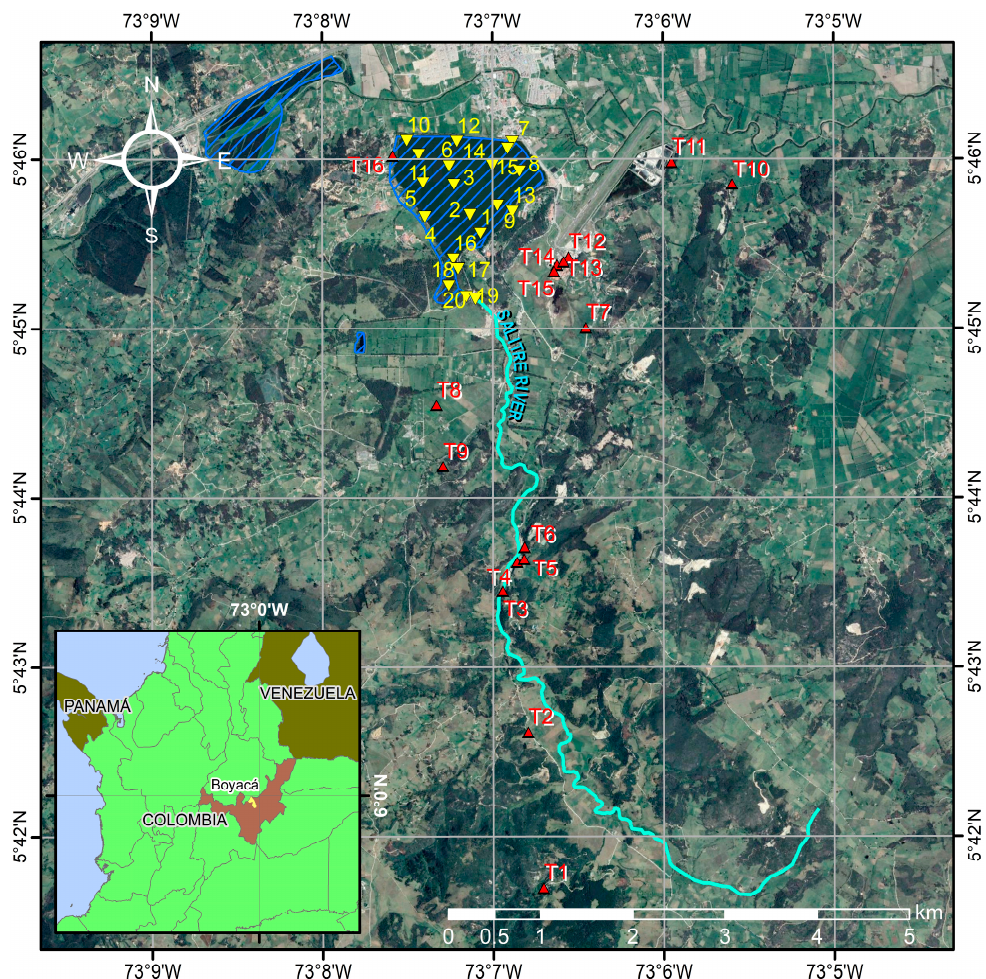
Figure 1. Geographical location of the study zone and identification of sample positions. Red points represent the hydrothermal springs, and the yellow points are the sites from the Sochagota Lake. Base map: Google Earth. The conceptual model of the Paipa geothermal system [21,22] considers that the heat source is magmatic and related to the Paipa volcano. The relationship between the geo- thermal system and the magmatic body is derived from their proximity. The main reser- voir of water is located in the old volcanic caldera formed at the end of the first eruptive epoch; in addition, a secondary reservoir relates to the quaternary sedimentary cover. The circulation of hot spring water occurs through faults (Figure 2). The discharge zone is structurally controlled, whereby hot fluids rise to the surface preferentially through fault- intersection zones. The primary recharge zone by infiltration is located in the southern mountains, at approximately 3500 m altitude; however, there is a local recharge area around the volcanic caldera.